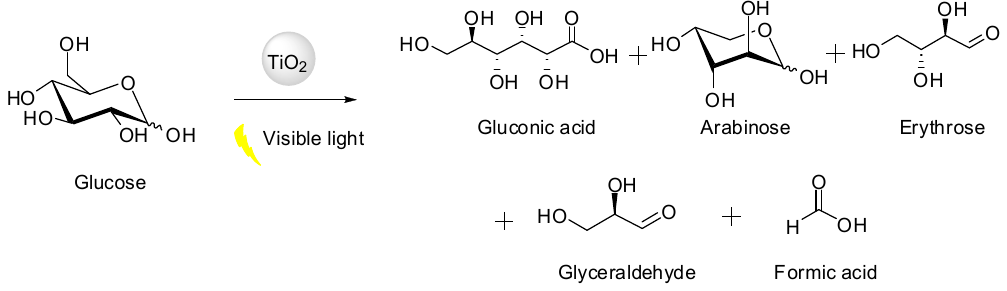
Table 2. Effects of solvent composition on glucose conversion and selectivity towards glucaric/gluconic acids using TiO 2 (US), Evonik P-25, TiO 2 /SiO 2 , and TiO 2 /Zeolite after 10 min of light irradiation from Colmenares et al. [27].